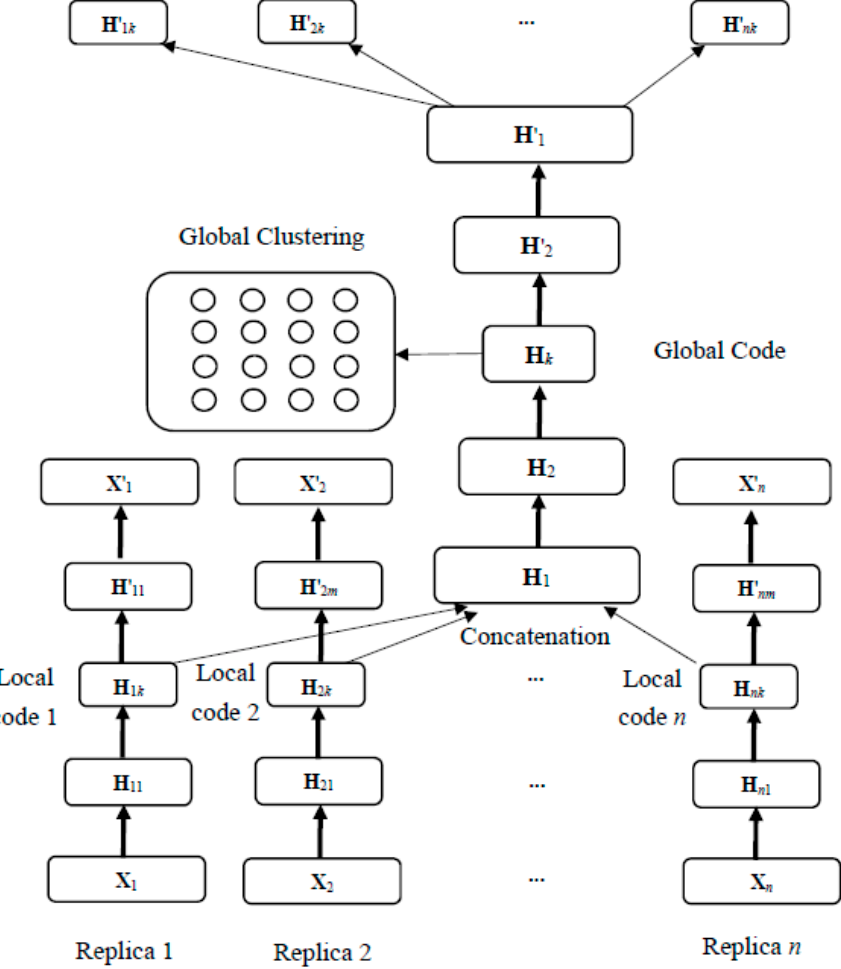
Figure 5. Structure of the double deep autoencoder.